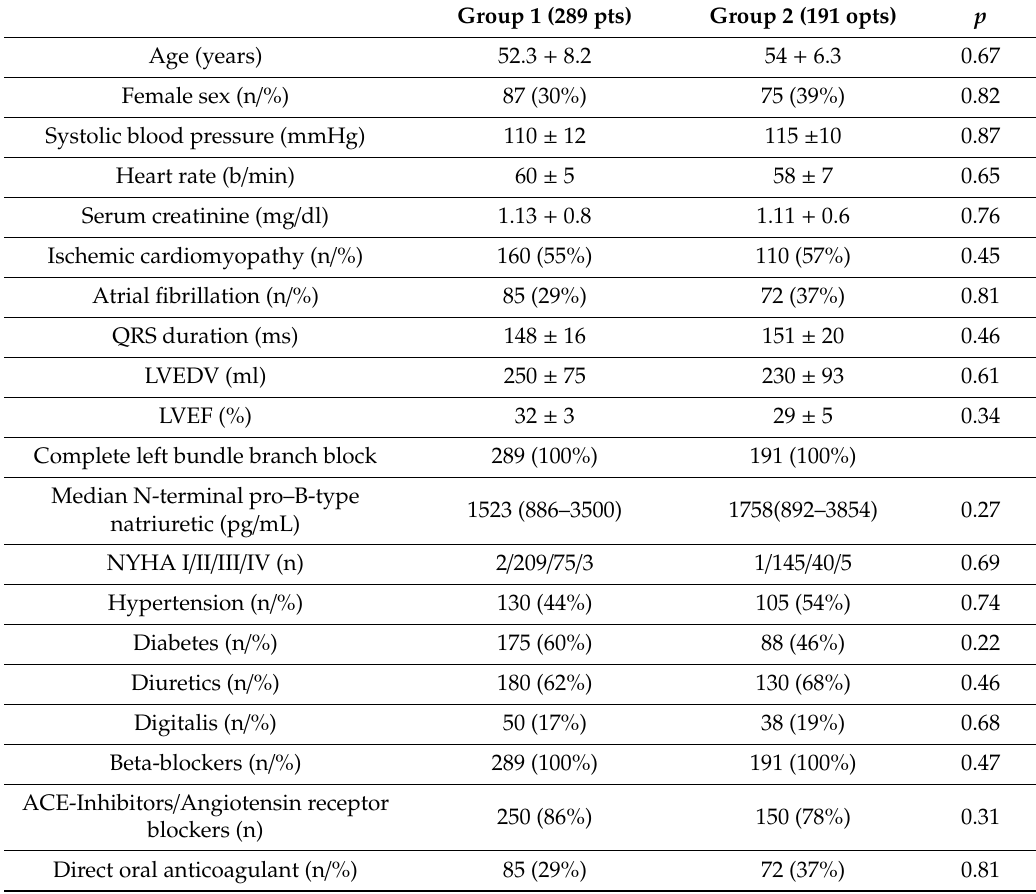
Table 3. Demographic and clinical characteristic according to β -blockers doses.